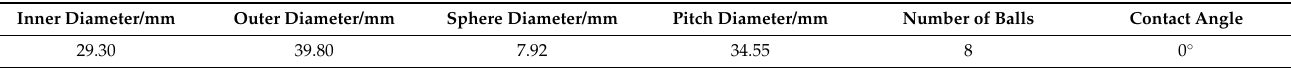
Table 4. LDK UER204 Bearing